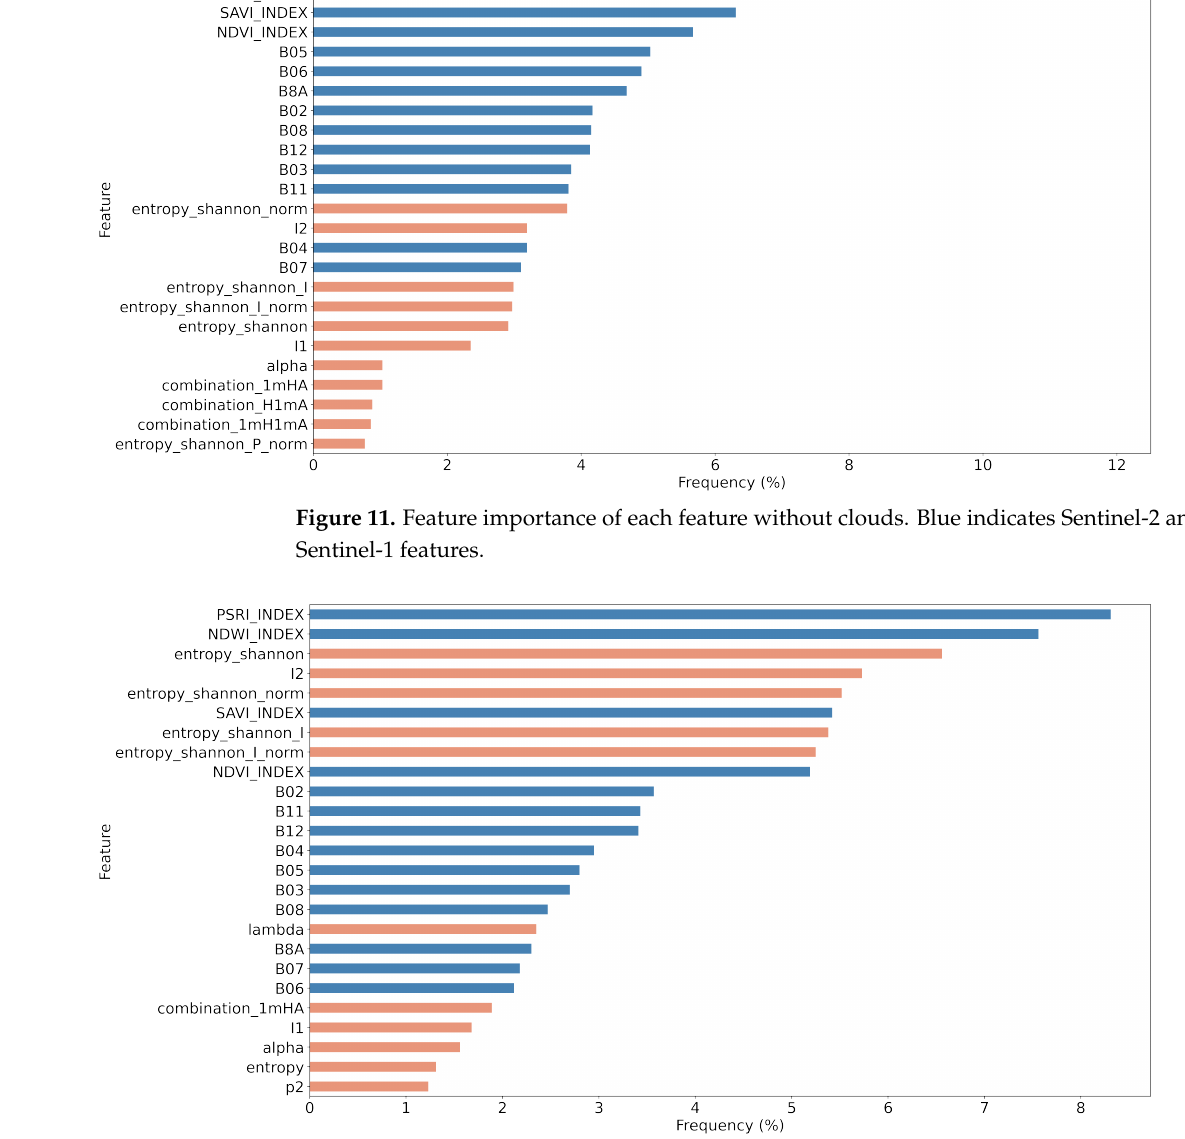
Figure 12. Feature importance of each feature with clouds. Blue indicates Sentinel-2 and orange Sentinel-1